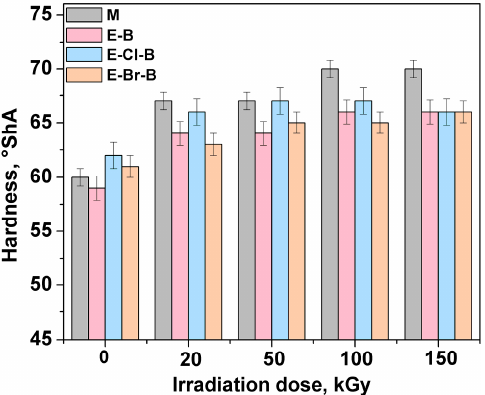
Figure 1. Hardness versus electron beam irradiation dose for EPDM/butyl rubber samples.